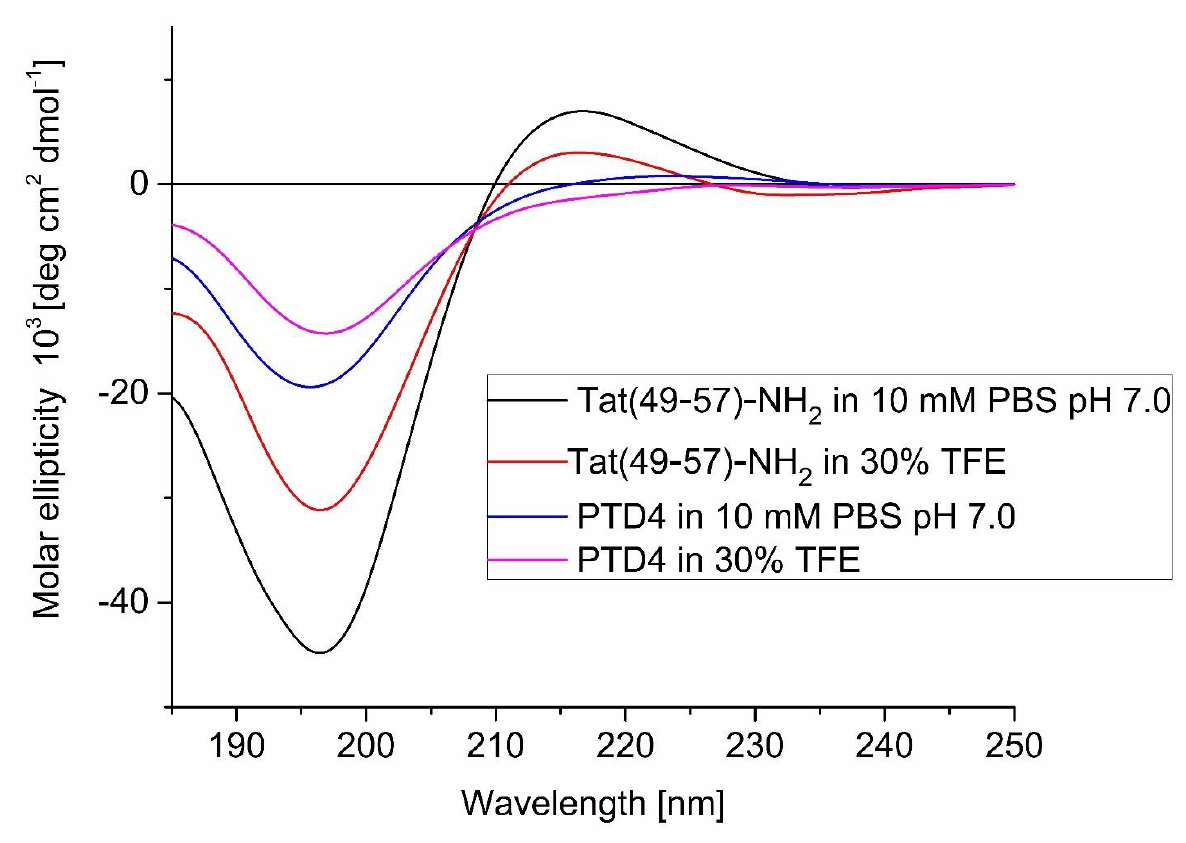
Figure 2. CD spectra of Tat(49–57)-NH 2 and PTD4 peptides in 10 mM PBS, pH 7.0 and 30% ( v / v ) TFE.